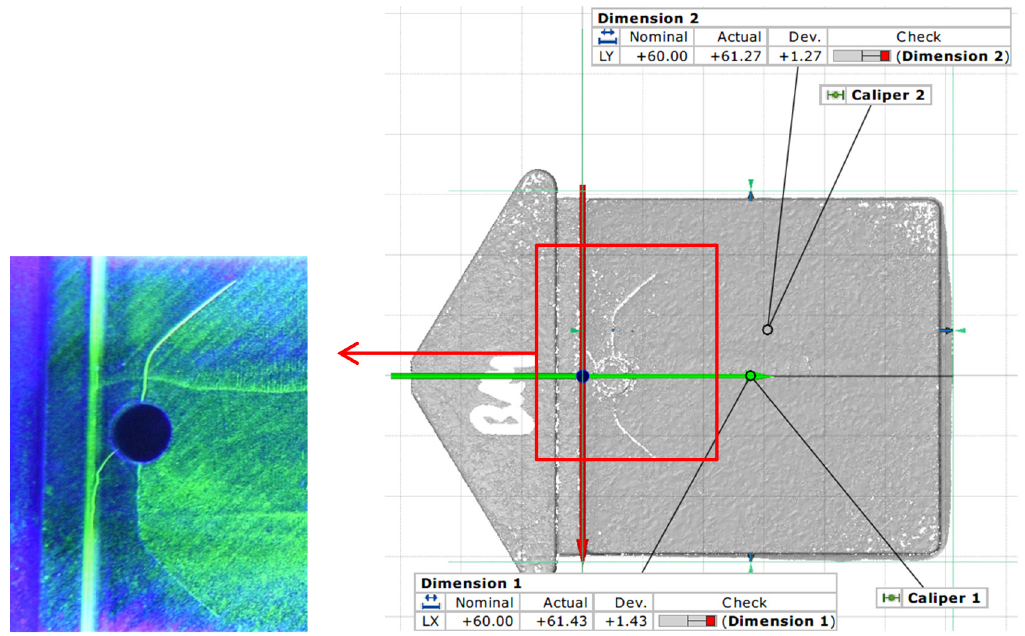
Figure 2. Cracks in the injection molding tool and accompanying PP specimen.